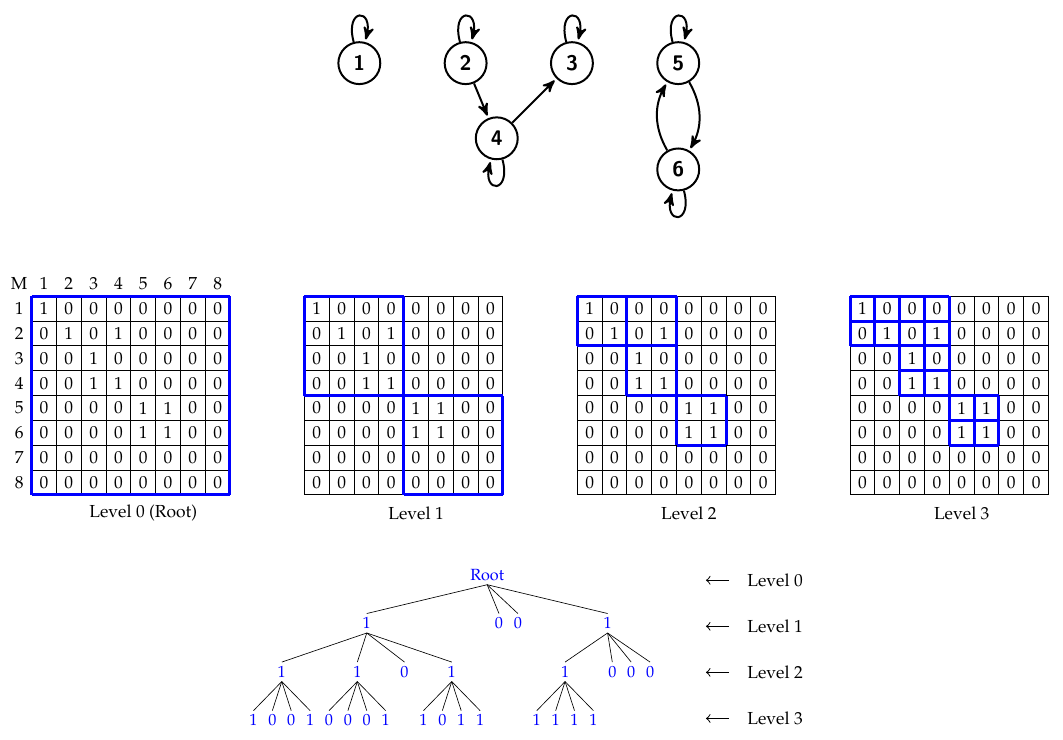
Figure 2. A graph of 6 nodes (top) with its 8 × 8 binary adjacency matrix at various stages of recursive partitioning. At the bottom, a k 2 -trees ( k =2) is constructed from the